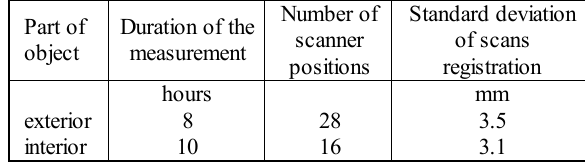
Table 4. Details of measuring